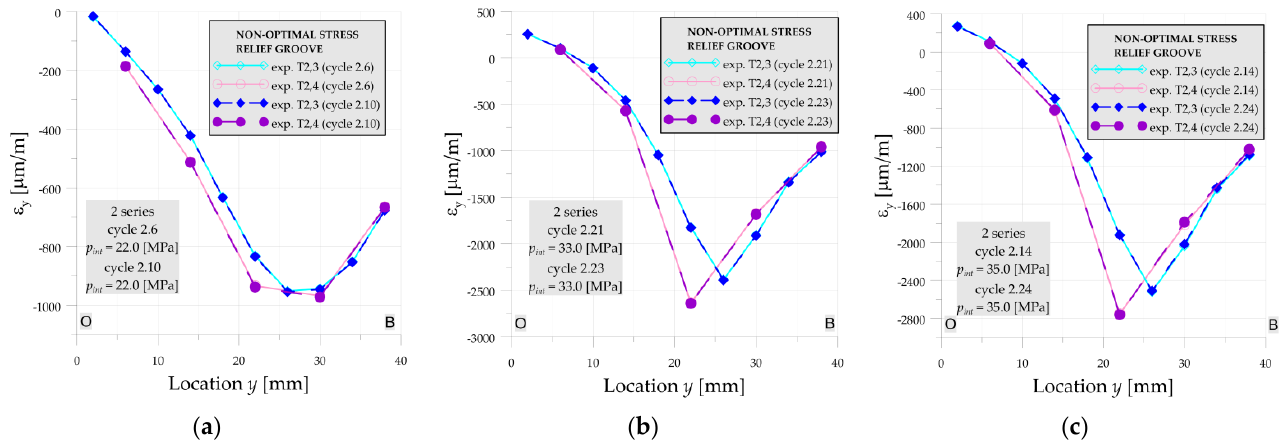
Figure A8. Repeatability of strain gauge measurements, optimal SRG, 2nd series: ( a ) cycles 6 and 10; ( b ) cycles 21 and 23; ( c ) cycles 14 and 24.